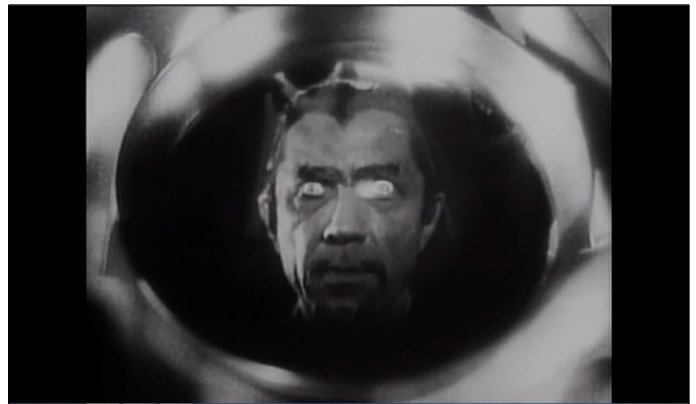
Figure 1. Murder Legendre’s gaze. The focus on Lugosi’s eyes, combined with the swirling, circular border of the frame emphasize the reference to mesmerism.